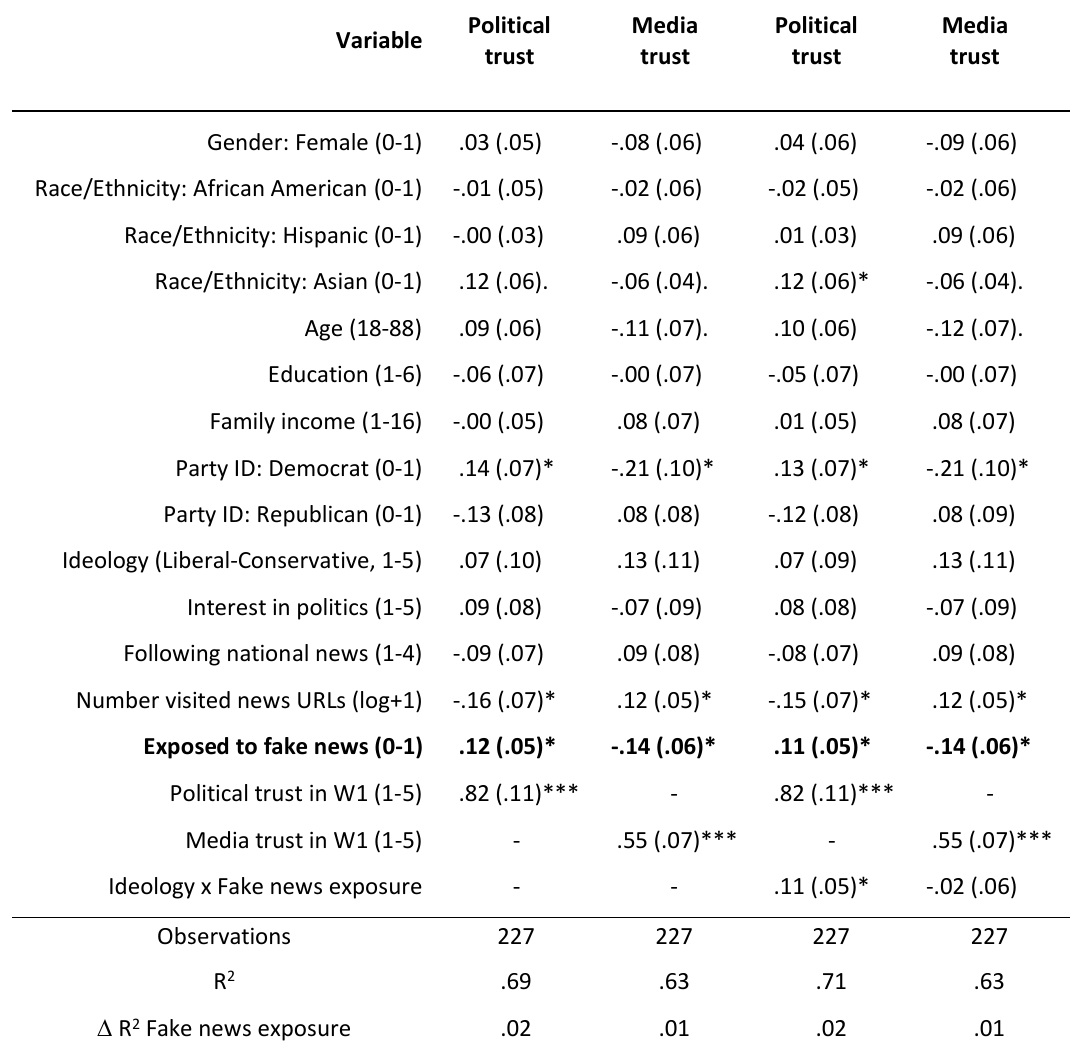
Table B2. Predictors political and media trust. The table includes standardized coefficients from ordinary least squares regressions with multiple imputation